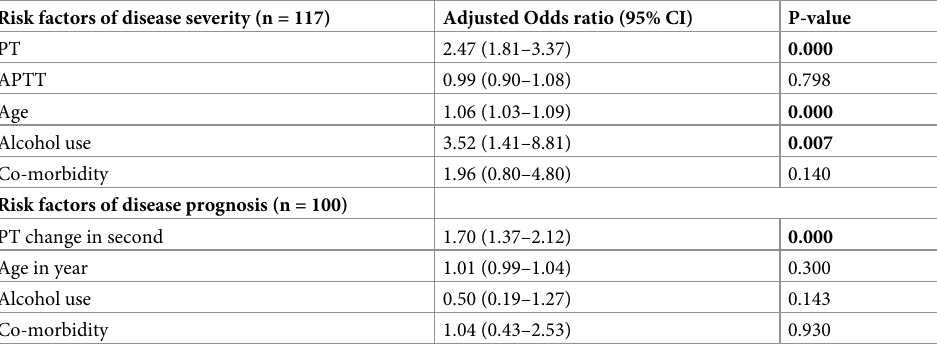
Table 8. Factors associated with COVID-19 disease severity among COVID-19 patients attending the Tibebe Ghion Specialized Hospital, COVID-19 treatment center 2021. Risk factors of disease severity (n =